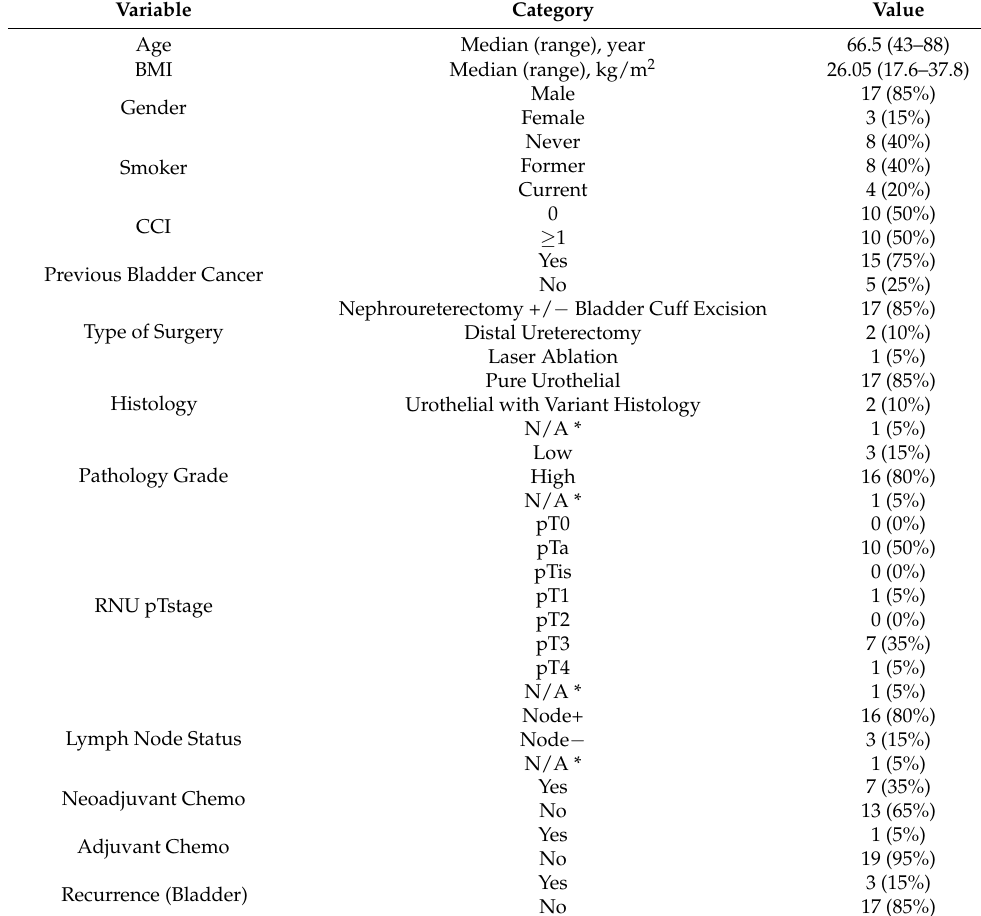
Table 1. Clinical demographics for UTUC patients. CCI = Charlson Comorbidity